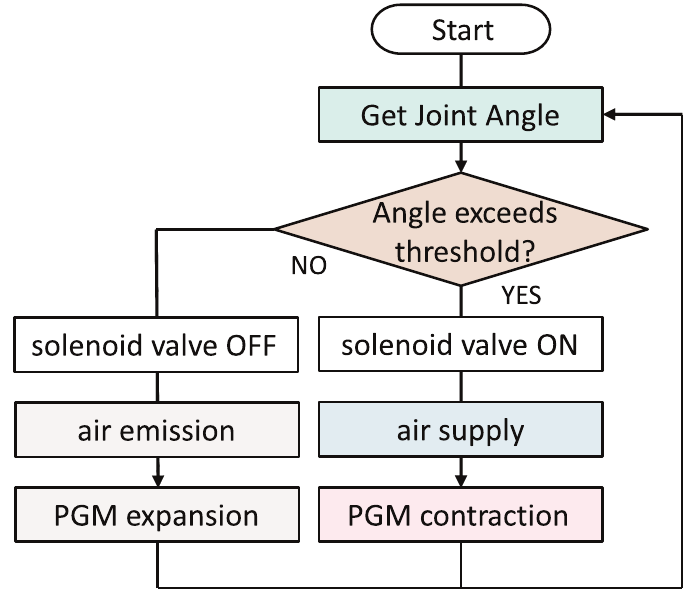
Figure 5. Process of running the PGM.